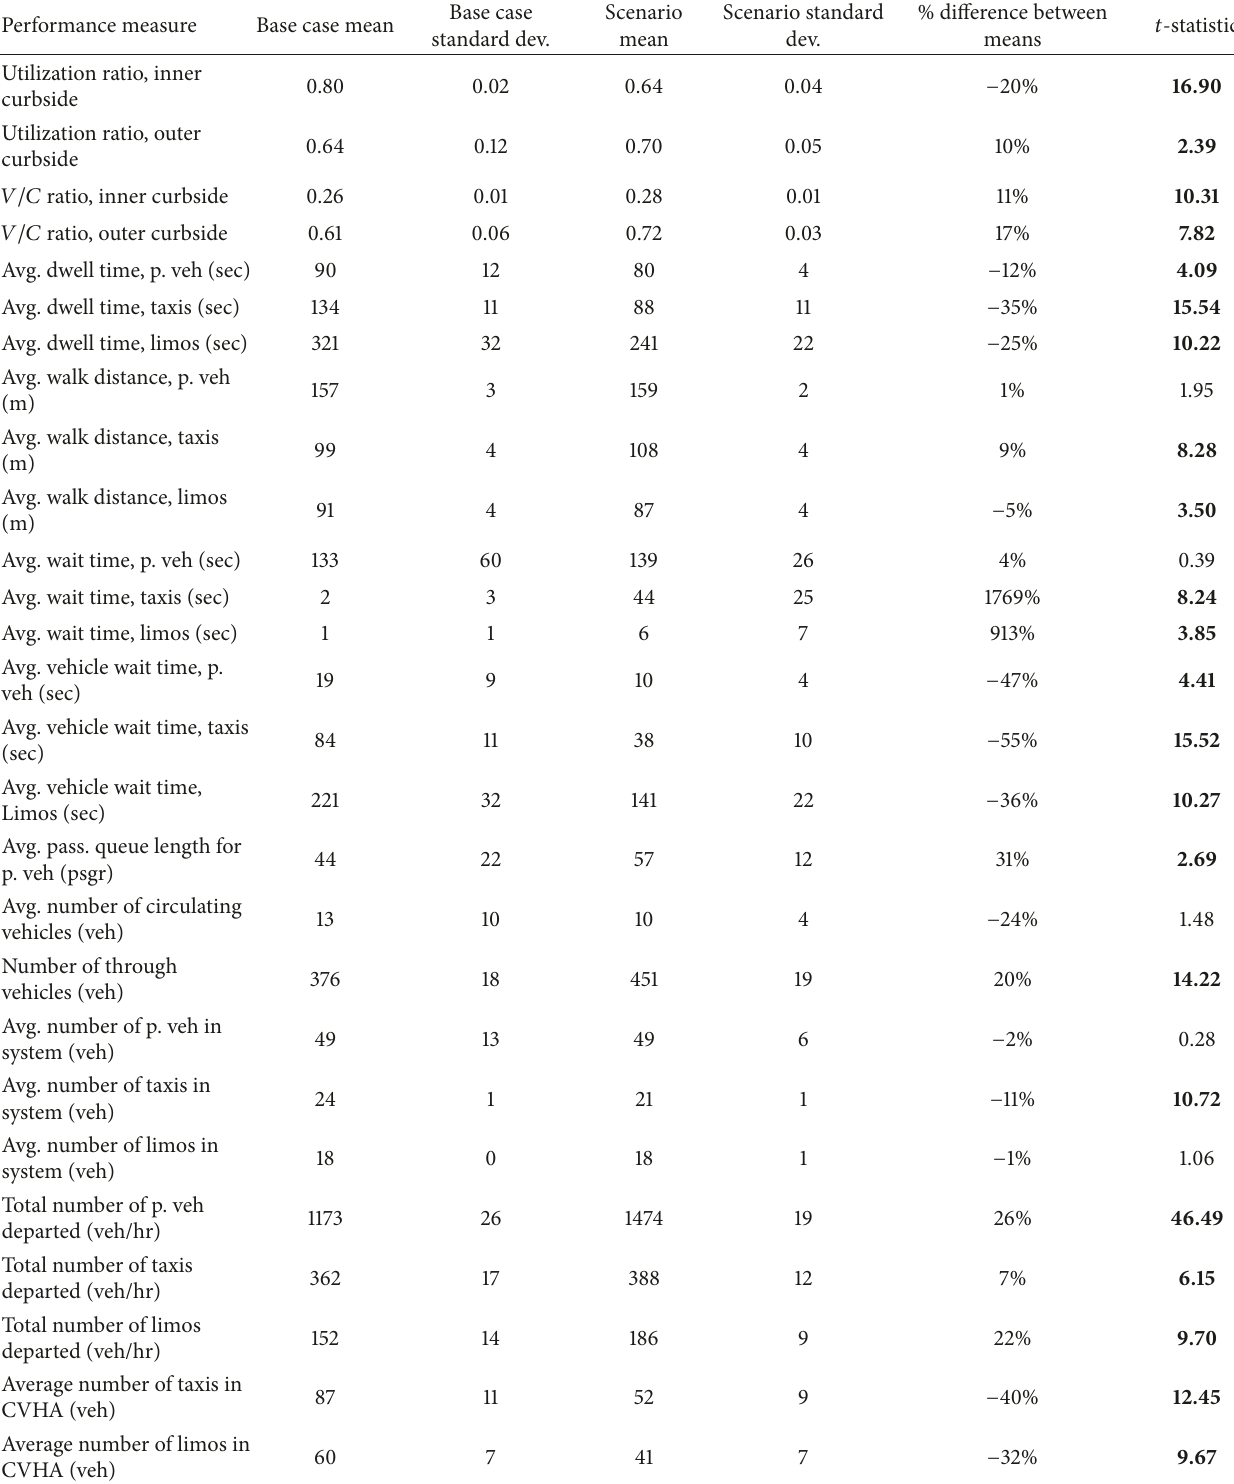
Table 4: Results for 25% increase in passenger demand (bold cells indicate that result is significantly different from the base case). Performance